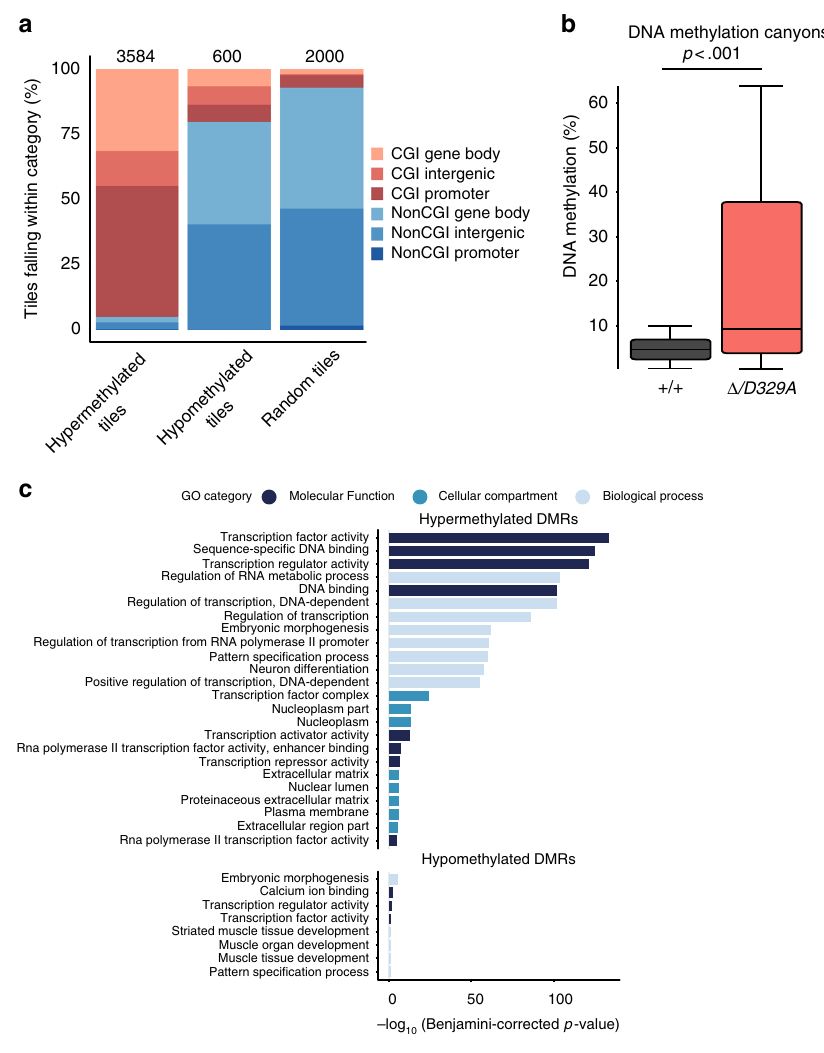
Fig. 5 Features of regions aberrantly methylated by DNMT3A D329A . a Percentages of hypermethylated and hypomethylated tiles (100-CpG) falling within the genomic features indicated compared with a random set of 100-CpG tiles (Supplementary Data 14). n (tiles) indicated on top of the bars. CGI: CpG island. b Distribution of methylation values over DNA methylation canyon probes 60 in Dnmt3a + / + and Dnmt3a Δ /D329A mice. n = 779, Mann – Whitney test ( p < 0.01, U A = 432,773, z = − 14.57). Boxplots show median value and 25 – 75th percentiles, whiskers show lowest and highest observation, excluding outliers. Source data are provided in Supplementary Data 12. c GO analysis of genes overlapping differentially methylated tiles. Unless there were fewer signi fi cant terms, the top 8 most signi fi cant terms per category are shown. Benjamini – Hochberg corrected p -value < 0.01 was used as a threshold.